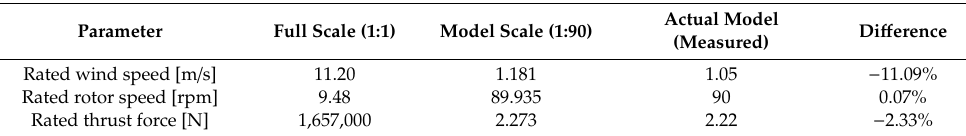
Table 4. Di ff erence between the actual and target conditions.